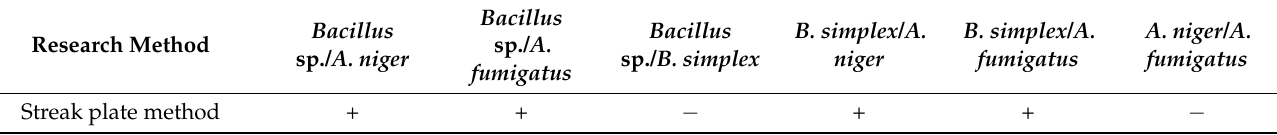
Table 7. Antagonistic activity of cultures (antagonist/test culture; + test positive; − test negative.).